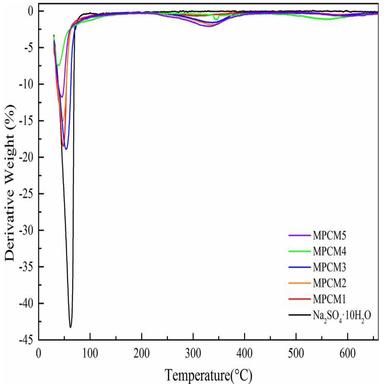
DTG curves for Na2SO4·10H2O and MPCM1–MPCM5.